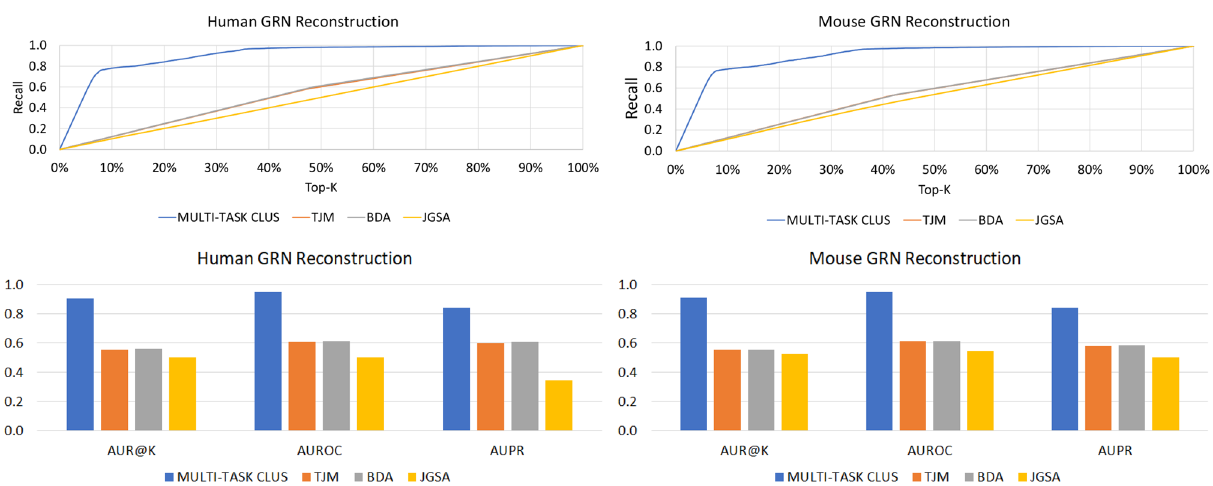
Figure 8. Recall@k (charts in the top) and AUR@K, AUROC and AUPR (charts in the bottom) results, obtained by our method (referred to as MULTI-TASK CLUS here) and its competitors.